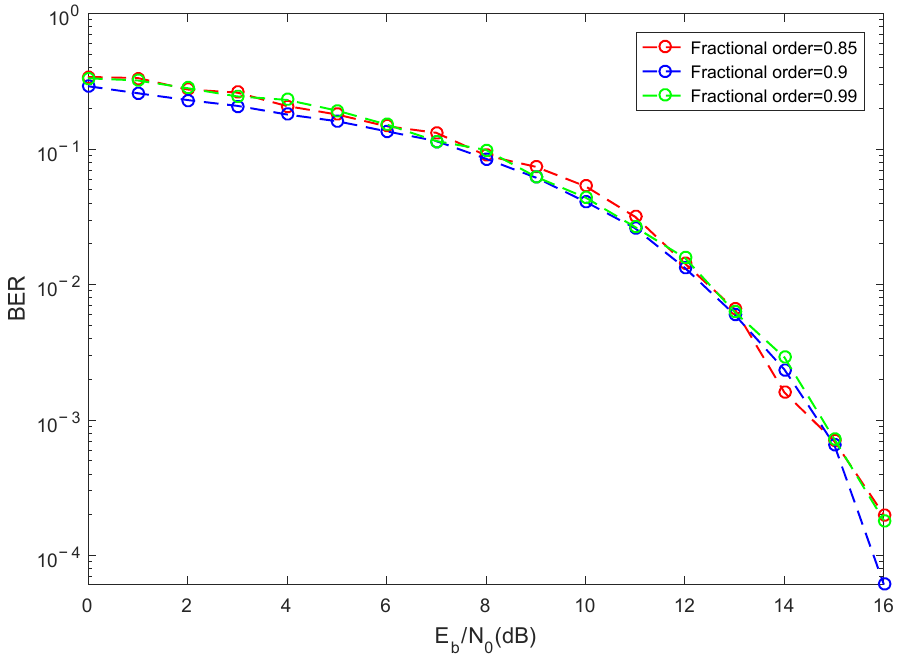
Figure 7. BER performance of the proposed MC-MDCSK-MCS with different fractional orders over the AWGN channel.